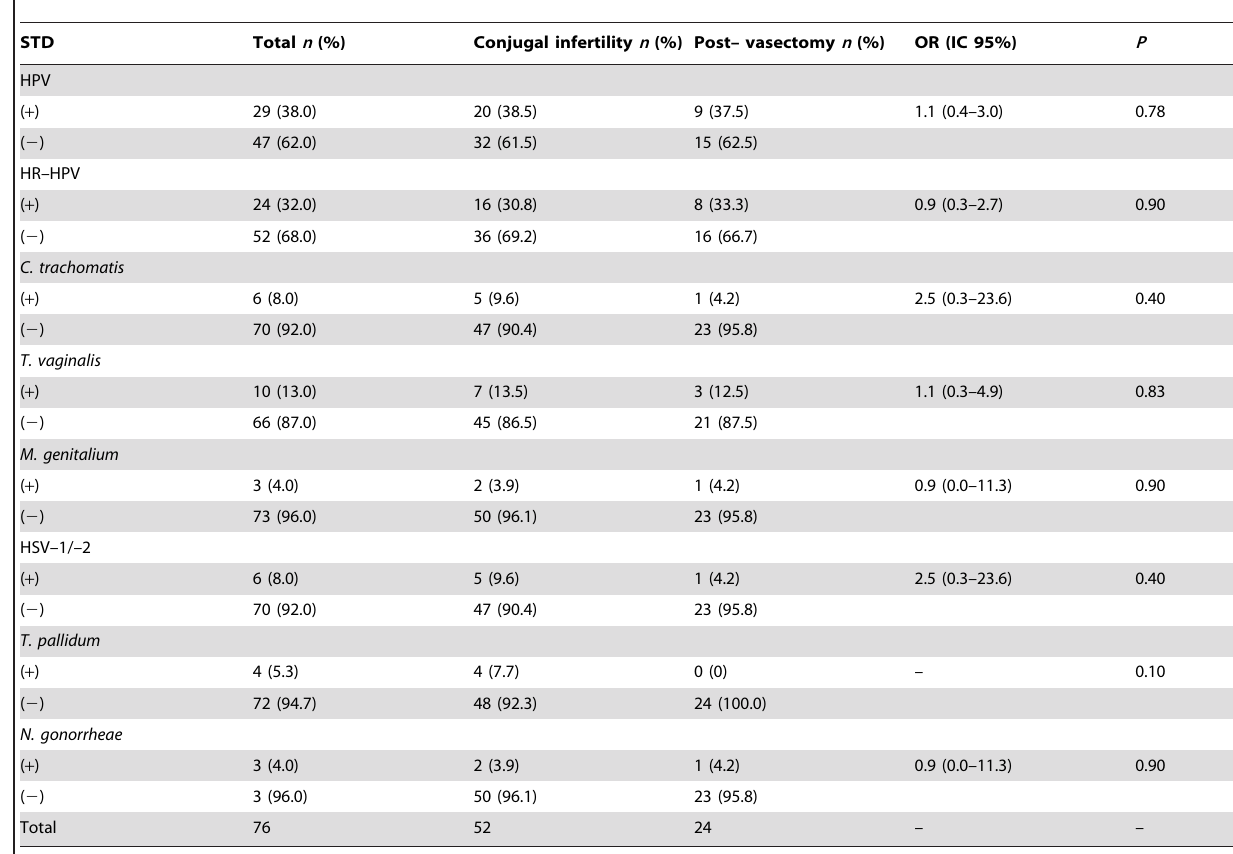
Table 3. Frequency of STDs and reason for performing the semen analysis.